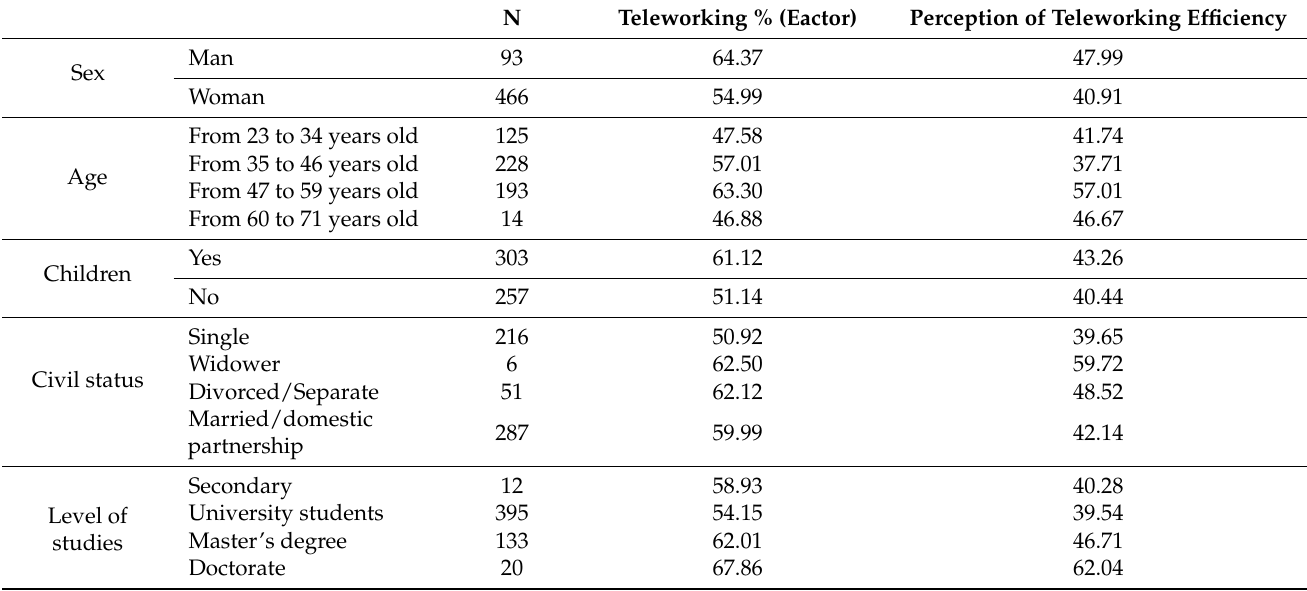
Table 3. Socio-demographic profile of telework in social services and perception of the effectiveness of this resource. N Teleworking % (Eactor) Perception of Teleworking